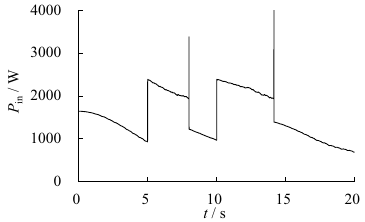
Figure 8. Input power of hydraulic system after optimization.